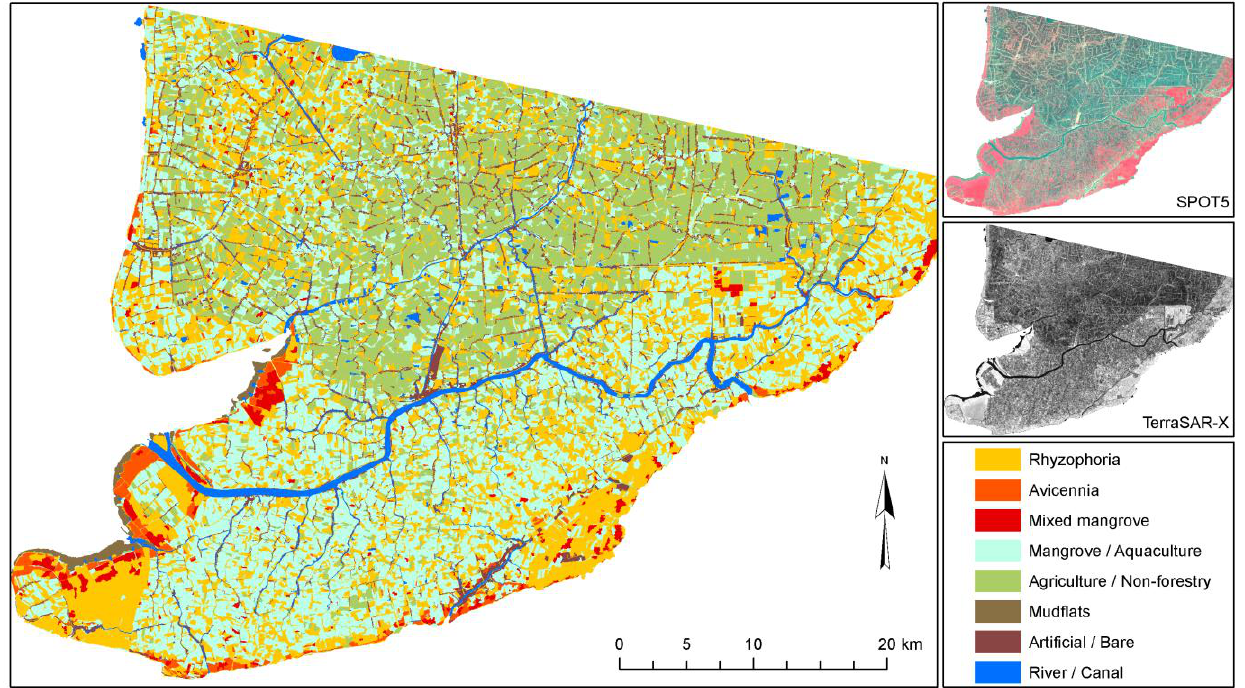
Figure 5. Example of a mangrove mapping result, based on a hybrid classification of SPOT 5 and TerraSAR-X data for Ca Mau Province in the Mekong Delta of Vietnam, 2010. Based on these two datasets, different species and different stand characteristics (mangroves only and mangroves mixed with aquaculture) can be